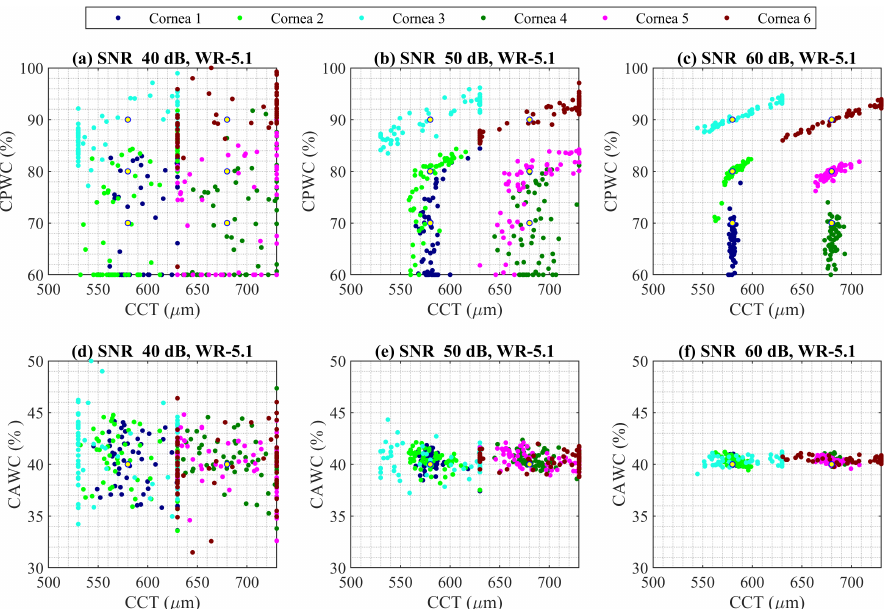
Figure 5. PSO analysis for extracting CPWC, CAWC, and CCT of six corneas at frequency band of WR 5.1 (140–220 GHz) considering SNR of ( a , d ) 40 dB, ( b , e ) 50 dB, and ( c , f ) 60 dB. Nominal values are shown with yellow dot and each cornea properties is plotted with different color.